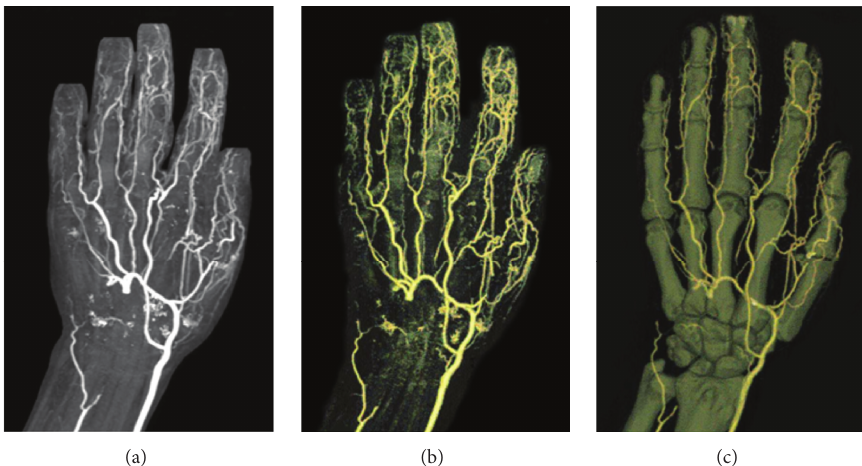
Figure 2: CT angiography of the right upper arm and tridimensional reconstructions ((a)–(c)). The follow-up three months later at the end of an intravenous iloprost course revealed a distal revascularization of the deep palmar arch and common digital